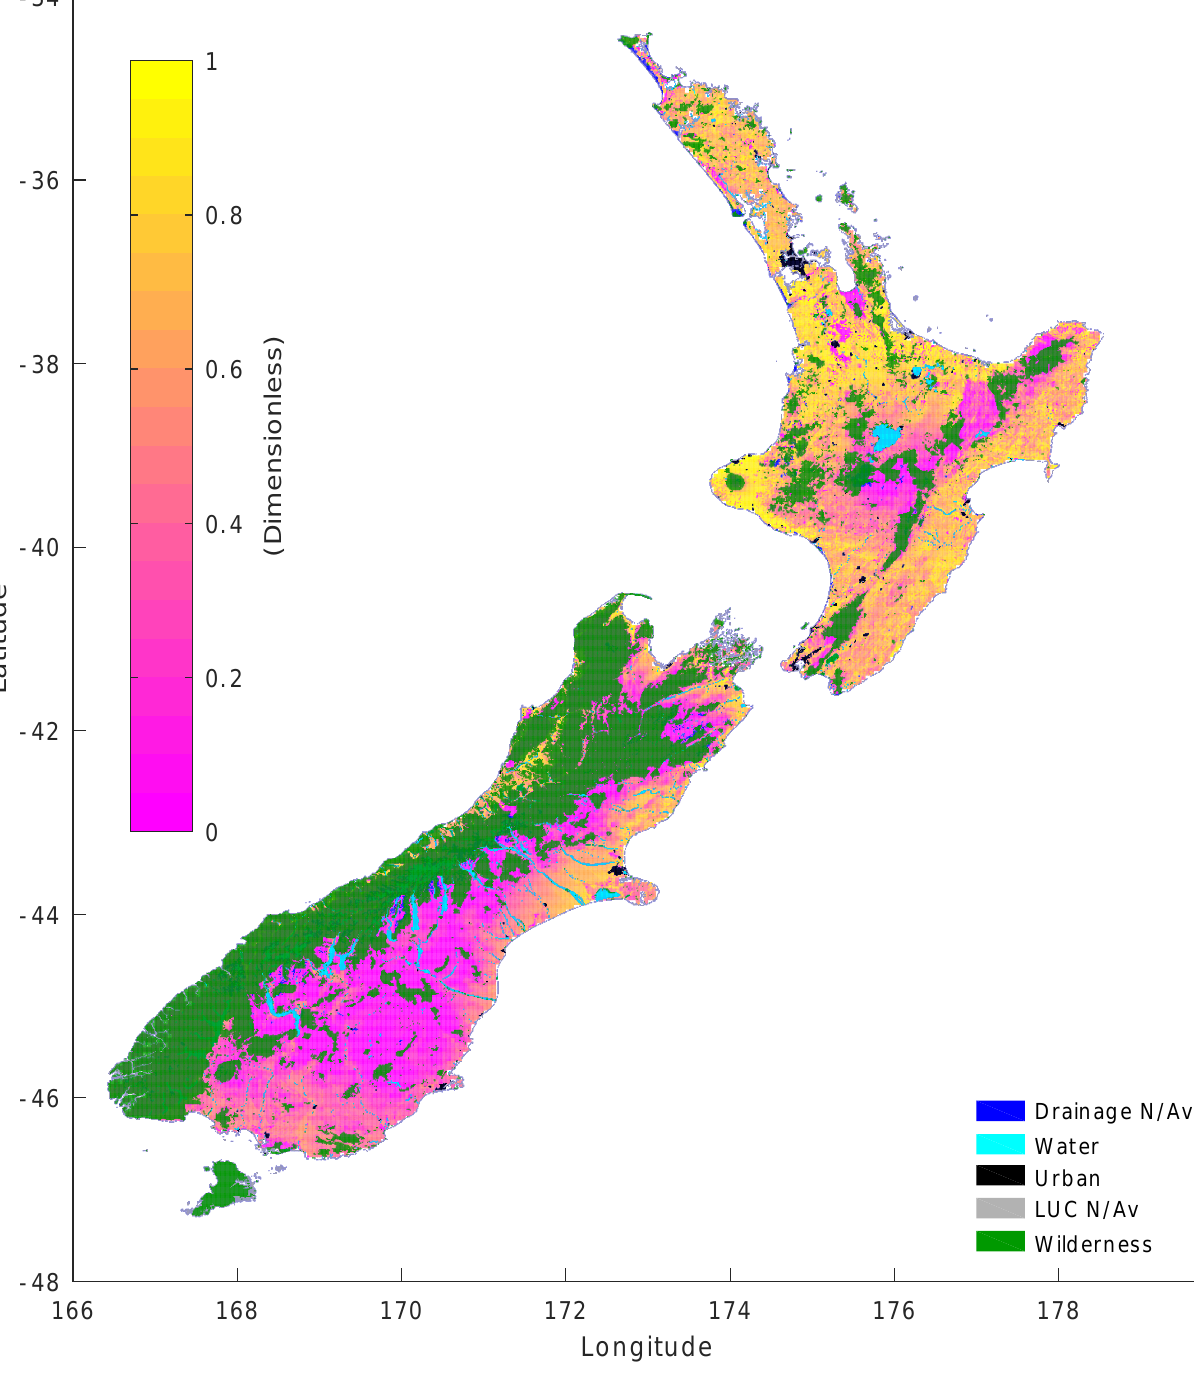
Figure 10. Location suitability scores for kiwifruit across New Zealand. N/av indicates data were not available. LUC is Land Use Capability classification. Wilderness areas encompass national parks, reserves, conservation areas and marginal